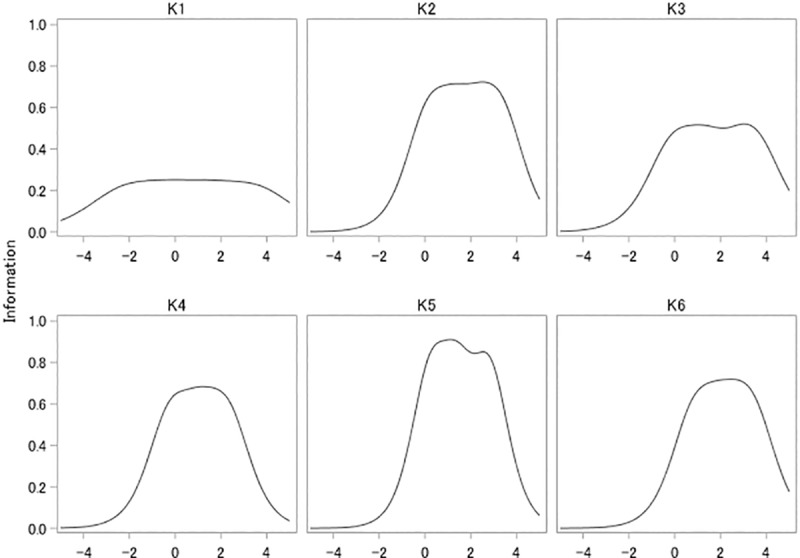
Test information curve of K6 among hospital nurses in Vietnam.The vertical axis indicates the latent trait of psychological distress.